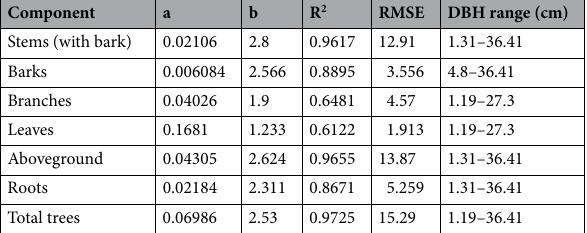
Table 4. Allometric equations relating biomass components (kg) to diameter at breast height (DBH, cm).